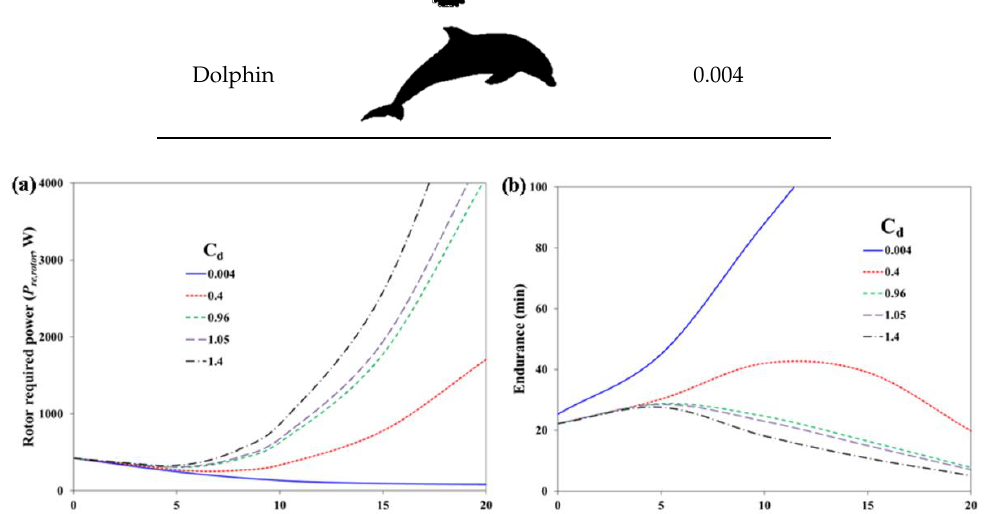
Figure 6. ( a ) Rotor required power; ( b ) estimated endurance with various drag coefficients. W is 14 kg, C 0 is 16,000 mAh and V 0 is 49 V.